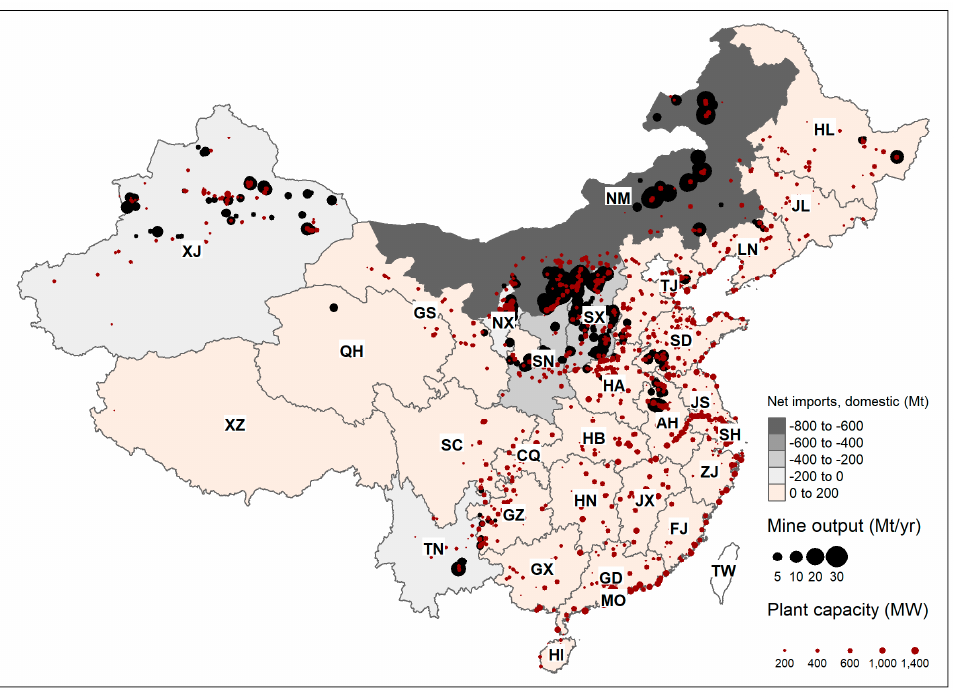
Figure 1. Estimated interprovincial trade balances for thermal coal in China by province (2021). Overlaid with coal mine output, and coal plants (operating and under construction), by capacity. See Appendix A for province codes.